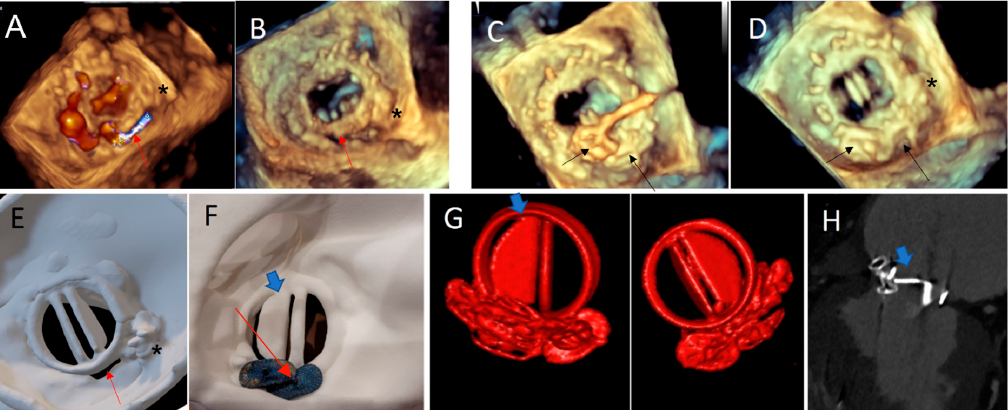
Figure 8. Case 5. ( A , B ) Paravalvular residual leak posteriorly (red arrow), in a patient with a previous history of transcatheter PVL closure treated by an AVP3 3–12 mm device (*): 3D TEE views; ( C ) PVL Closure with two additional AVP3 devices: 5–14 and 5–12 mm (black arrow); ( D ) normal opening of the mechanical leaflets and no residual gap at the end of the procedure on 3D TEE view. Note the two AVP 3 devices (black arrow) and the previous one (*); ( E ) atrial view of the 3D printed model showing the PVL close to the hinge of the mechanical mitral discs. Note the 3D print of the pre-existing AVP 3 (*); ( F ) post procedural simulation on 3D printing model: using the same AVP 3 devices: demonstrating a disc interference (blue arrow) in ventricular view; ( G ) 3D volume rendering of the prosthesis with a partial blockage of the external disc (blue arrow), in both ventricular and atrial view, occurred late in the postoperative period, similar to testing on the 3D printed model. ( H ) Internal Disc blockage in 2D CT view (blue arrow).